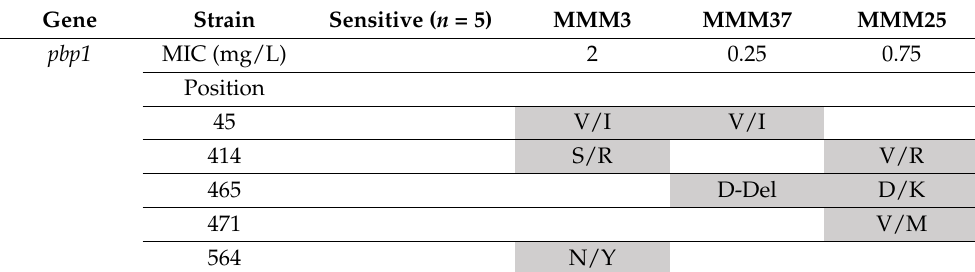
Table 3. Mutations in pbp-1 gene that were associated with AMX-resistance.